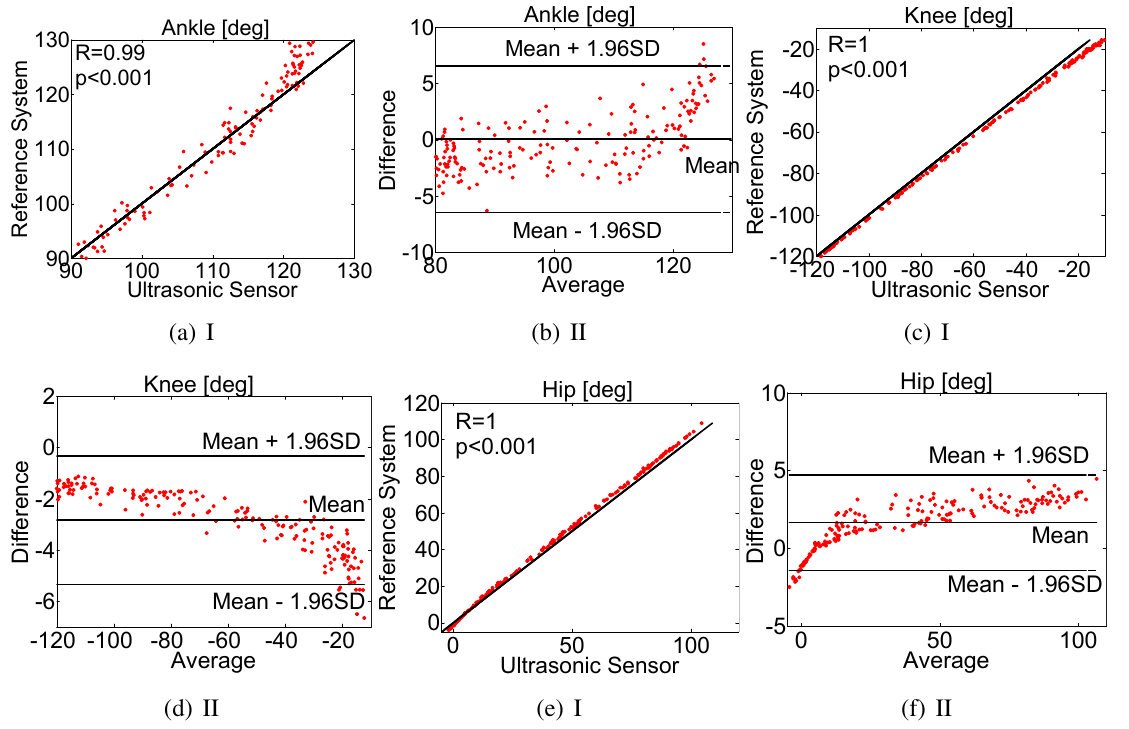
Figure 5. (I) Joint angles estimated by the proposed ultrasonic and reference camera-based measurement system, plotted with the line of equality. ( a ) Ankle joint angle; ( c ) knee joint angle and ( e ) hip joint angle. (II) Bland–Altman plot with the mean and difference between two values estimated by the proposed ultrasonic and reference camera-based measurement system, plotted with the limits of agreement, which are the average difference ± 1.96-times the standard deviation of the difference. ( b ) Ankle joint angle; ( d ) knee joint angle and ( f ) hip joint